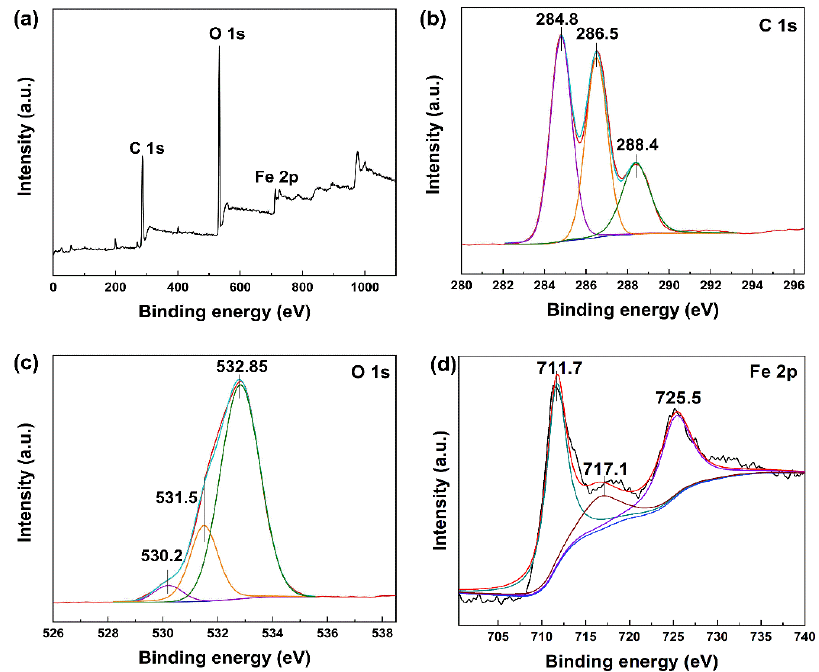
Figure 3. XPS spectra of MIL-101(Fe): ( a ) survey scan, ( b ) C 1s (61.7%), ( c ) O 1s (35.2%) and ( d ) Fe 2p (3.1%).